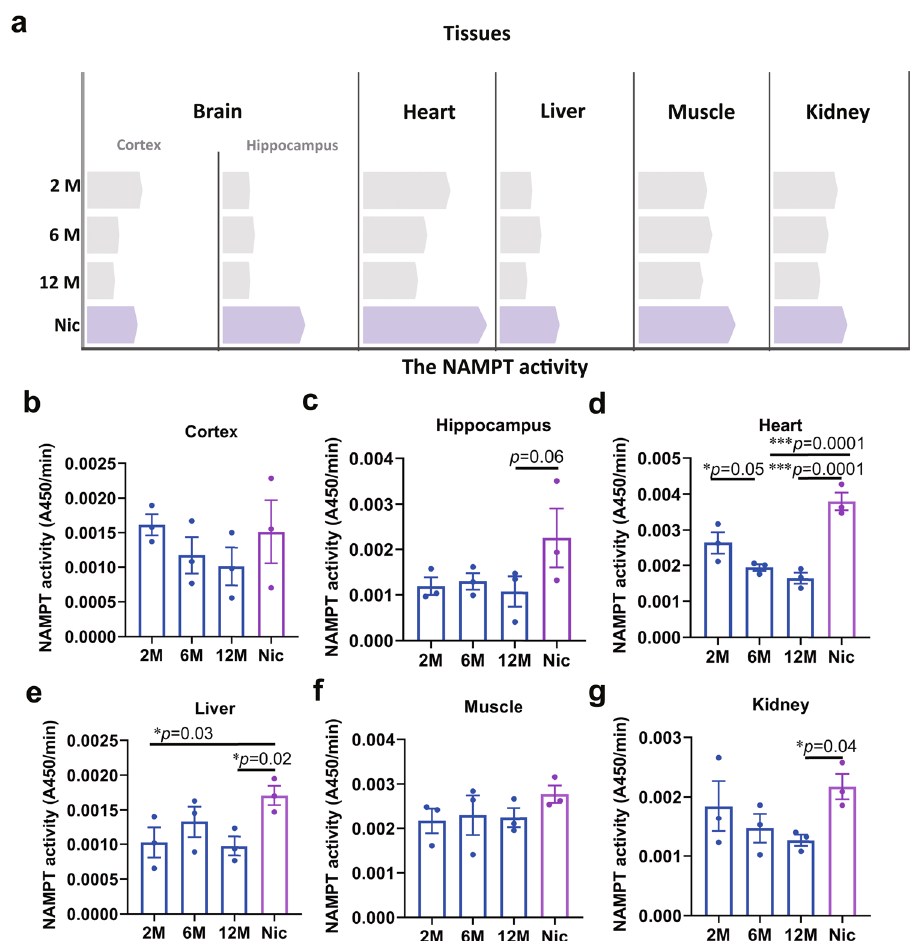
Fig. 1 | Nicotineenhanced NAMPT activityin agedmice. a Schematic diagramof the changes in NAMPT activity and nicotine enhancing NAMPT activity in various tissues(thebarsrepresentthemeanvalueofNAMPTactivity).Statisticaldiagramof NAMPT activity change of different tissues: b Cortex, c Hippocampus, d Heart,